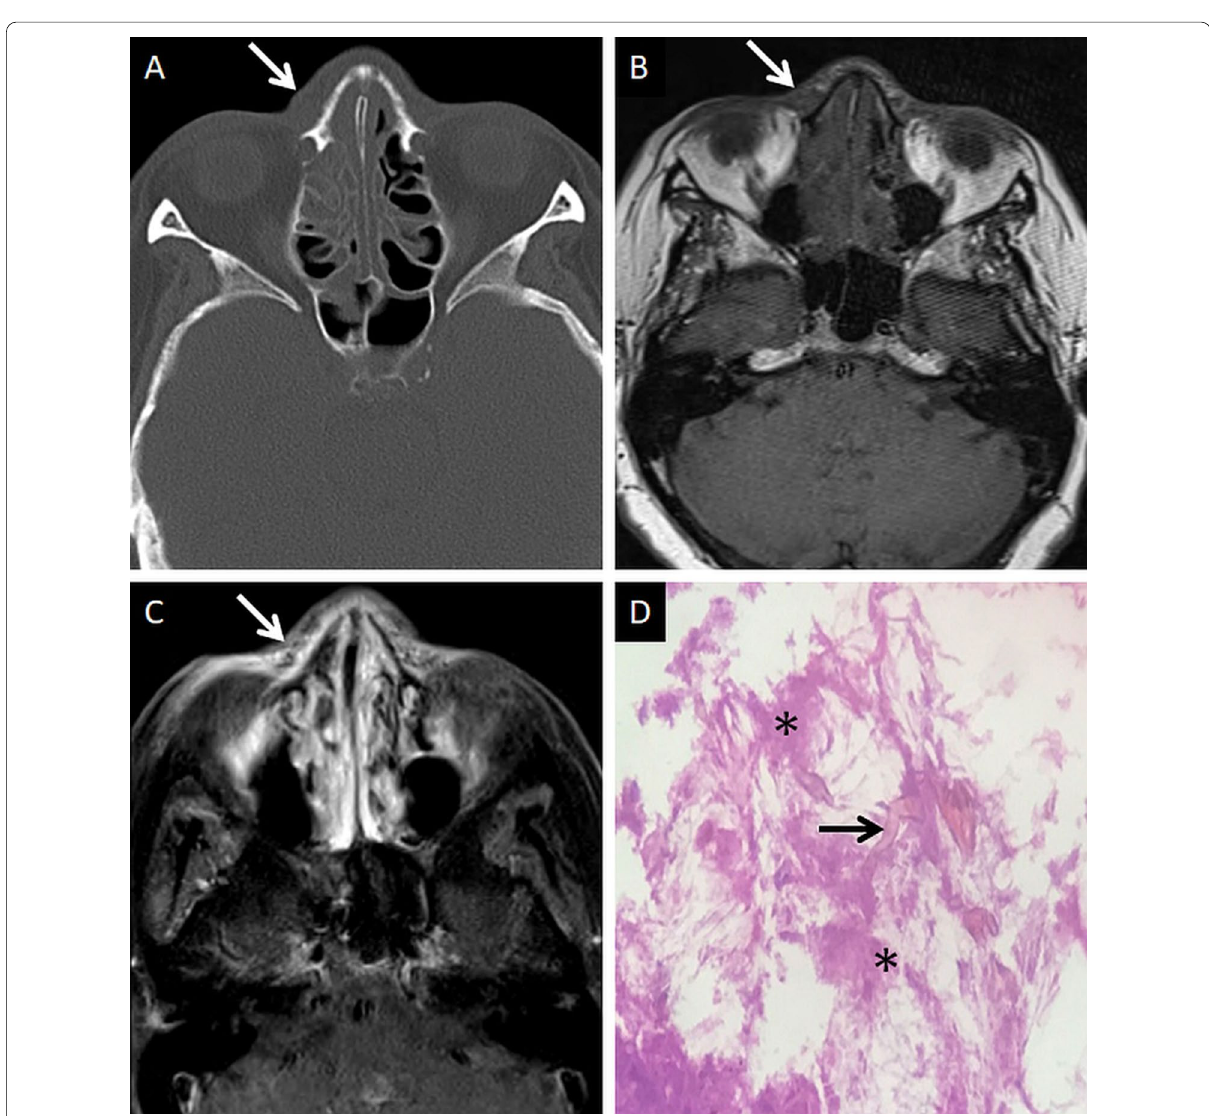
Fig. 7 Extra-sinus involvement without bone destruction. Axial CT scan ( a ) of the paranasal sinuses, obtained using the bone algorithm, reveals opacification of the ethmoid air cells, rarefaction of its trabeculae in addition to subtle swelling along the nasal bridge (thick arrow). No overt erosion of the nasal bones, nasolacrimal duct or the lamina papyracea is seen. Unenhanced axial T1W image ( b ) confirms the subcutaneous soft tissue (thick arrow) detected on the CT. CE FS axial T1W image ( c ) demonstrates heterogeneous enhancement of the nasal soft tissue (thick arrow). Post-debridement histopathology analysis ( d ), using HE staining, confirms branching, aseptate fungal hyphae (thick arrow), consistent with MCR,